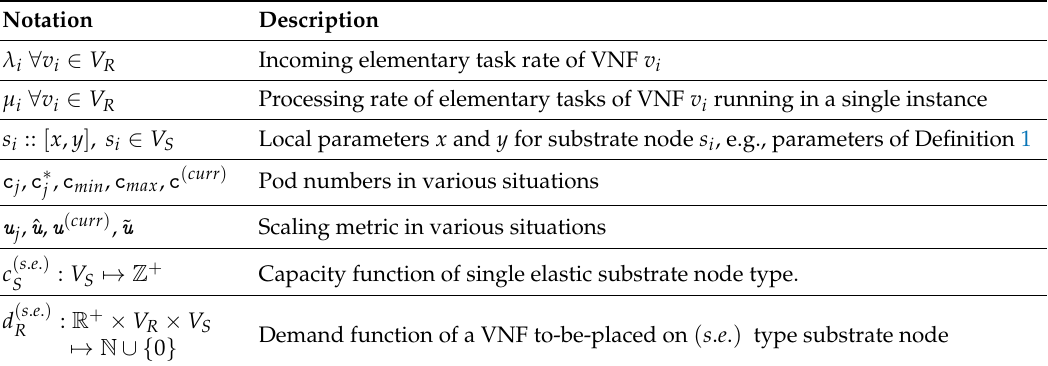
Table 5. Notations for modeling the elasticity of substrate